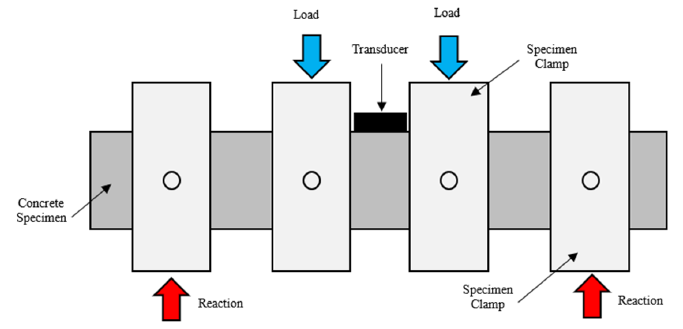
Figure 3. Schematic of the 4PB test from the elevation point of view.